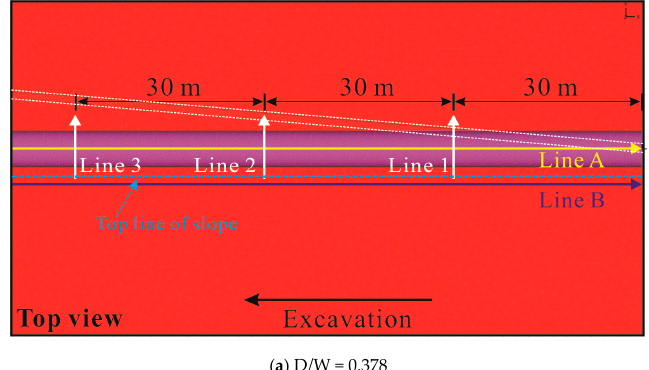
Table 5. The medium parameters in the finite element physical and mechanical